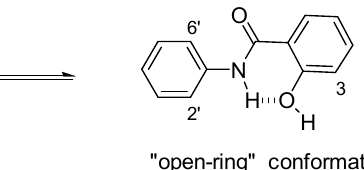
Figure 3. Conformational equilibrium in salicylanilide molecules. Two possible intramolecular hy- drogen bond formations resulting in closed-ring or open-ring conformation [52] .